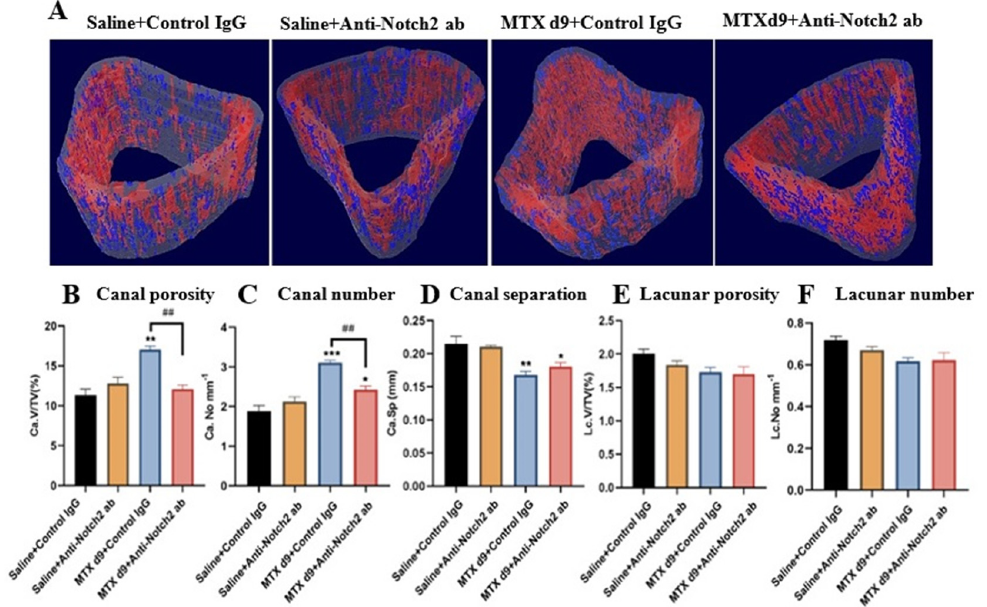
Figure 3. Treatment effects on tibial metaphyseal cortical bone vasculature canals and osteocyte lacuna porosities at day nine after initial MTX dose. ( A ) Representative micro-CT 3D images form control and different treatment groups illustrating the segmentation of the cortical bone vasculature canals (red) and osteocyte lacuna network (blue). ( B ) Vascular canal porosity (Ca.V/TV, %). ( C ) Average vascular canal number (Ca.No, per mm). ( D ) Vascular canal separation (Ca.Sp, mm). ( E ) Osteocyte lacunar porosity (Lc.V/TV, %). ( F ) Osteocyte lacunar number (Lc.No, per mm). All measurements expressed as mean ± SEM. * p < 0.05, ** p < 0.01 and *** p < 0.001 compared to the control; and ## p < 0.01 compared between MTX treatment